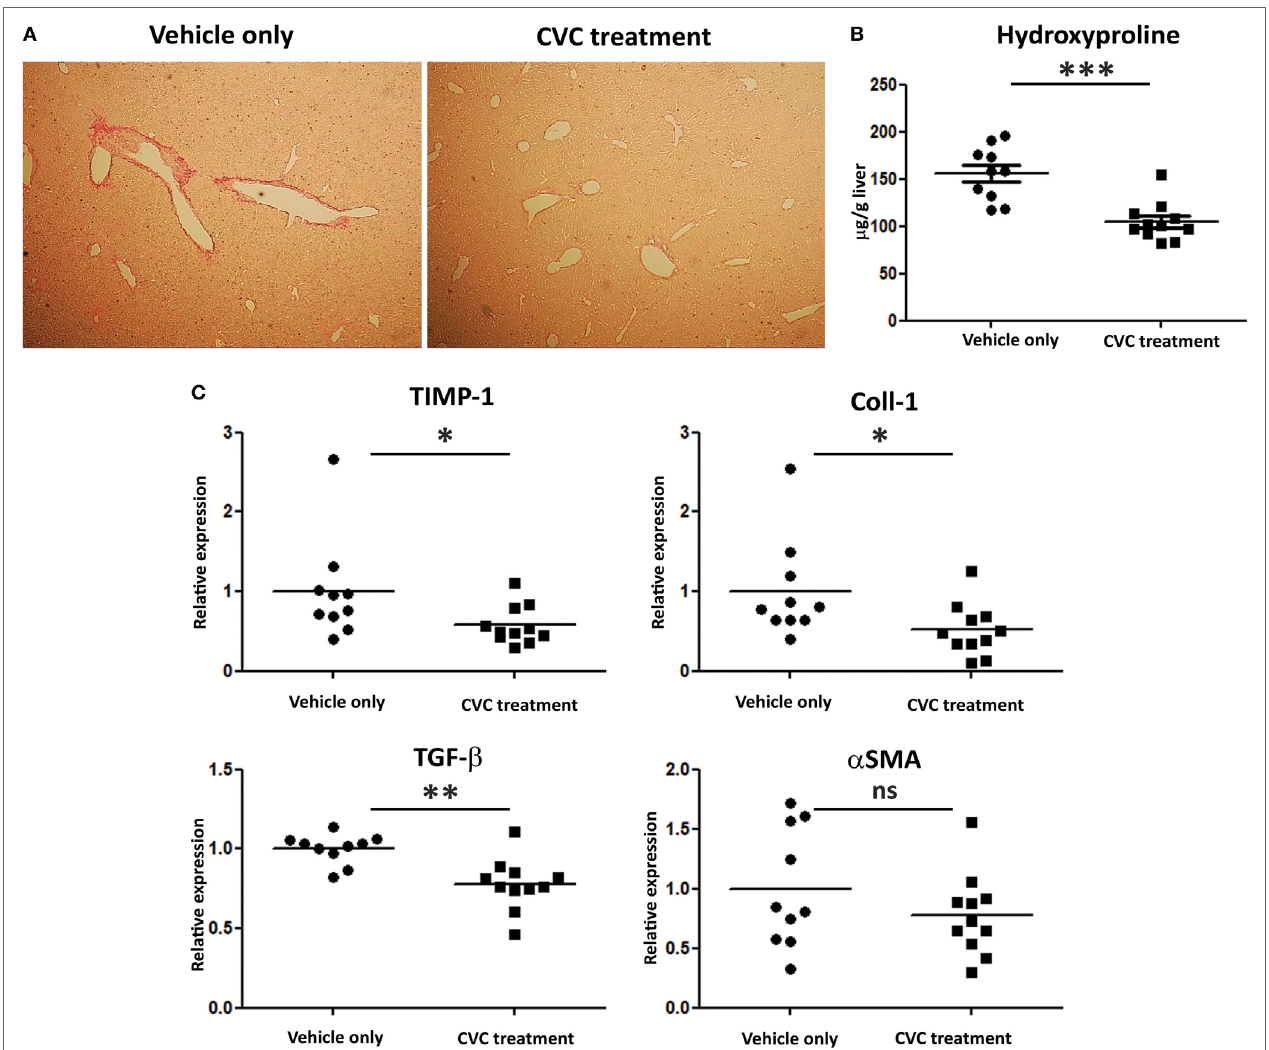
FigUre 6 | CVC treatment prevents the development of hepatic fibrosis in the 2-octynoic acid conjugated to bovine serum albumin autoimmune cholangitis model. (a) Representative liver sections from indicated mice—Picro-Sirius red staining. (B) Graphical summary of hepatic hydroxyproline content quantification in indicated mice groups. (c) Graphical summary of hepatic expression levels of fibrosis-associated genes of indicated mice groups. Results are mean ( n ≥ 10) for each group. Results are representative of two independent experiments. * p < 0.05, ** p < 0.01, and *** p < 0.001 (unpaired Student’s t